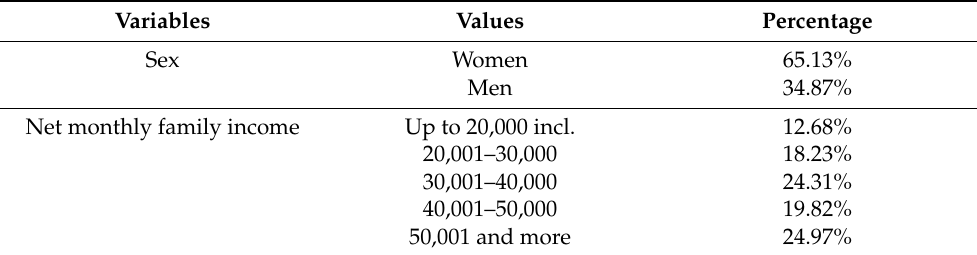
Table 1. Relative distribution of respondents in individual categories. Variables Values Percentage Sex Women 65.13% Men Net monthly family income Up to 20,000